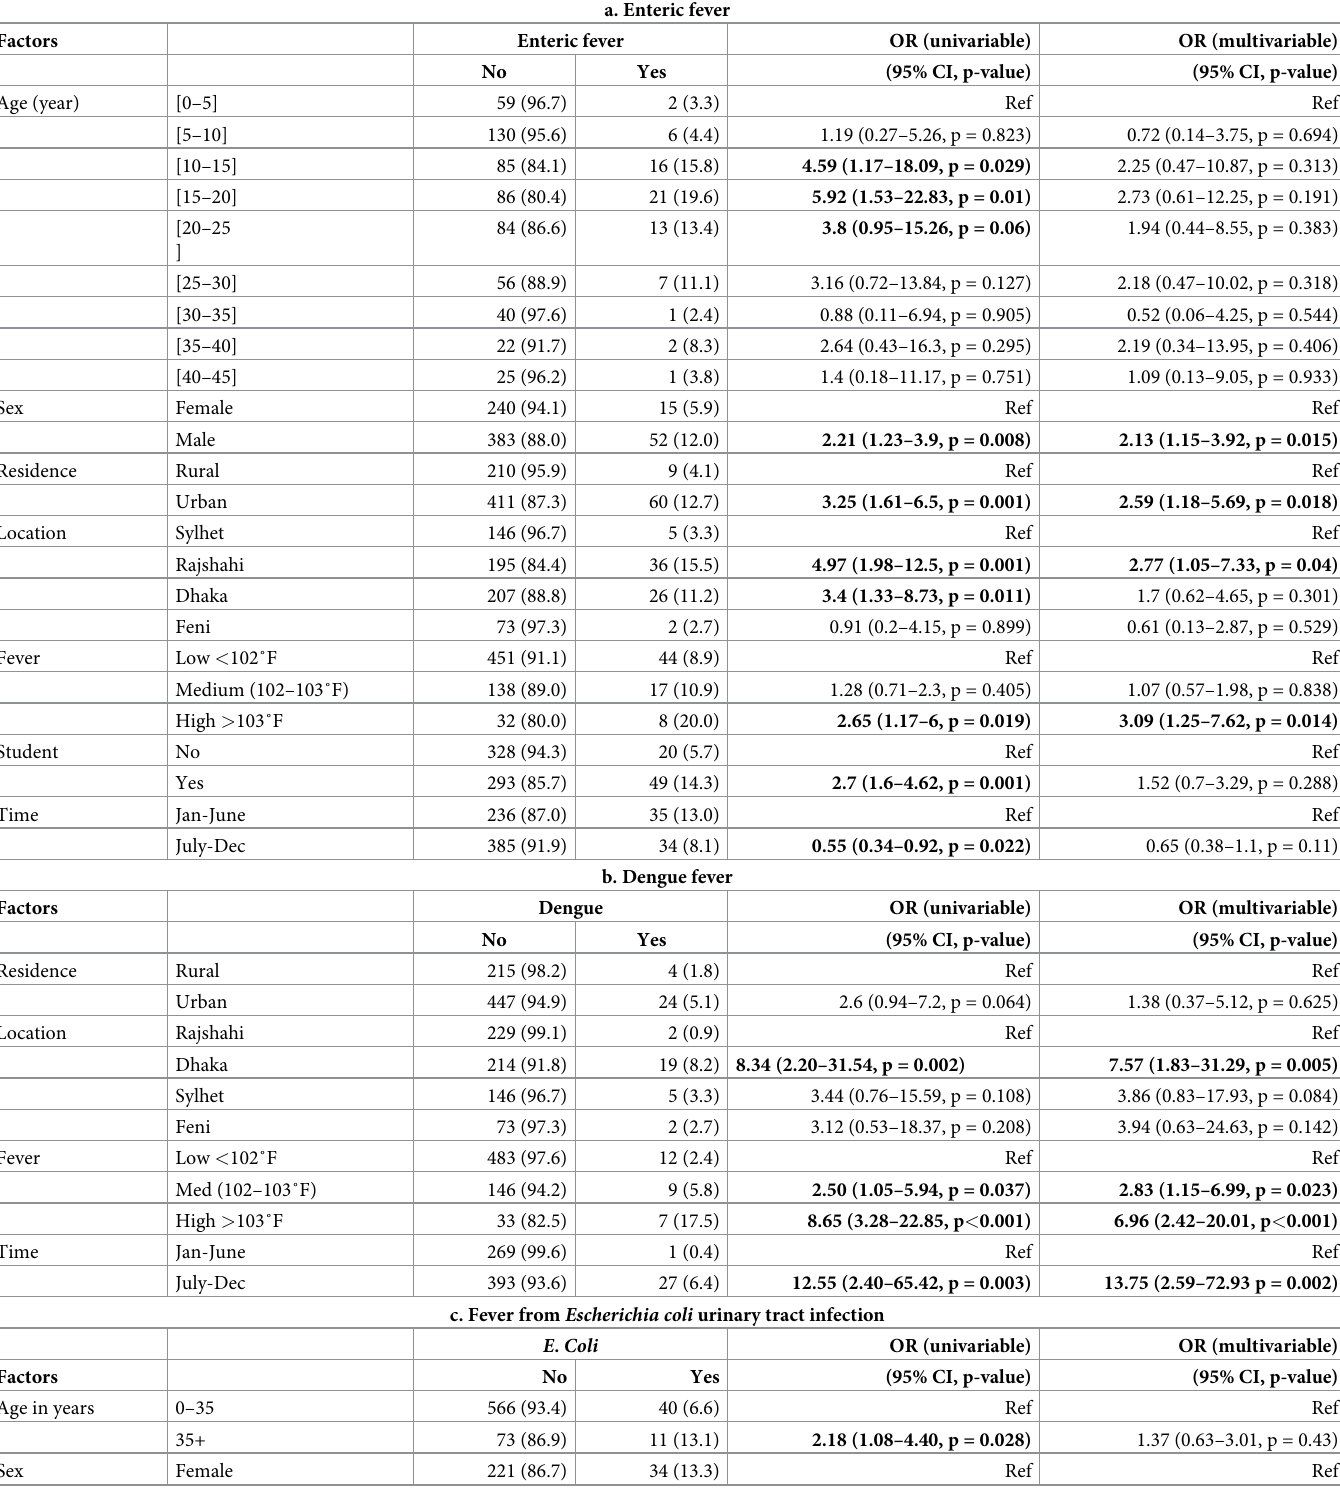
Table 3. Univariate and multivariate regression models for pathogens commonly detected in acute febrile illness (AFI) surveillance in Bangladesh, May 2019-March 2020.